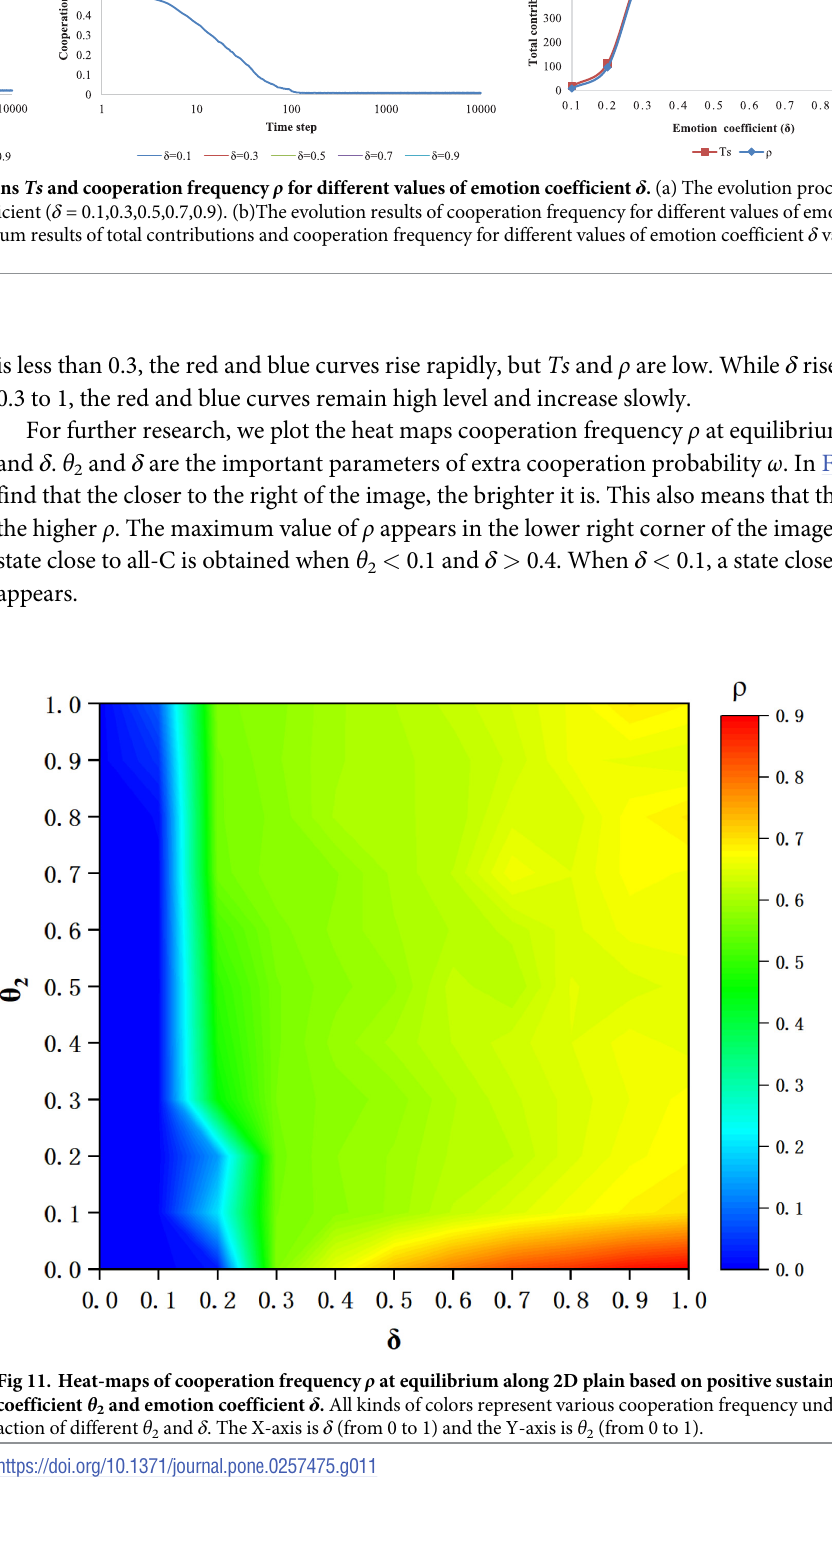
PLOS ONE | https://doi.org/10.1371/journal.pone.0257475 September 20,